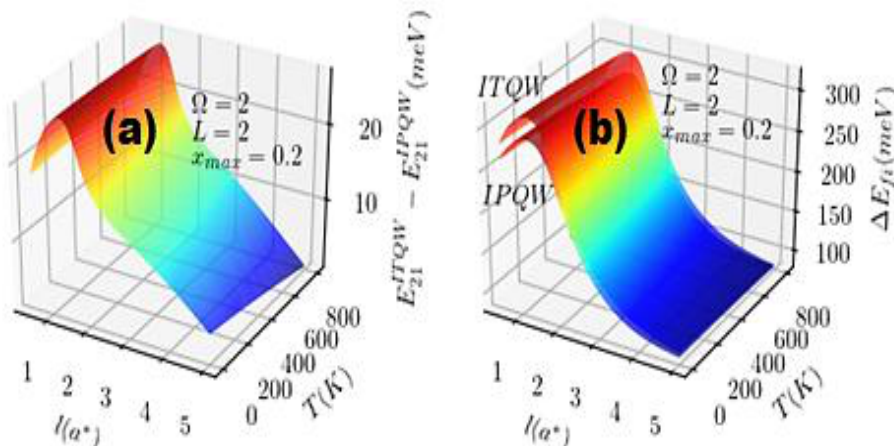
Figure 3: The variation of the difference of energy between both of them (ITQW and IPQW) (a) and that of them separately (B) versus the well width (x-axis) and temperature (y-axis) with a fixed barrier width (L=2) and x =0.2 and Ω=2. max